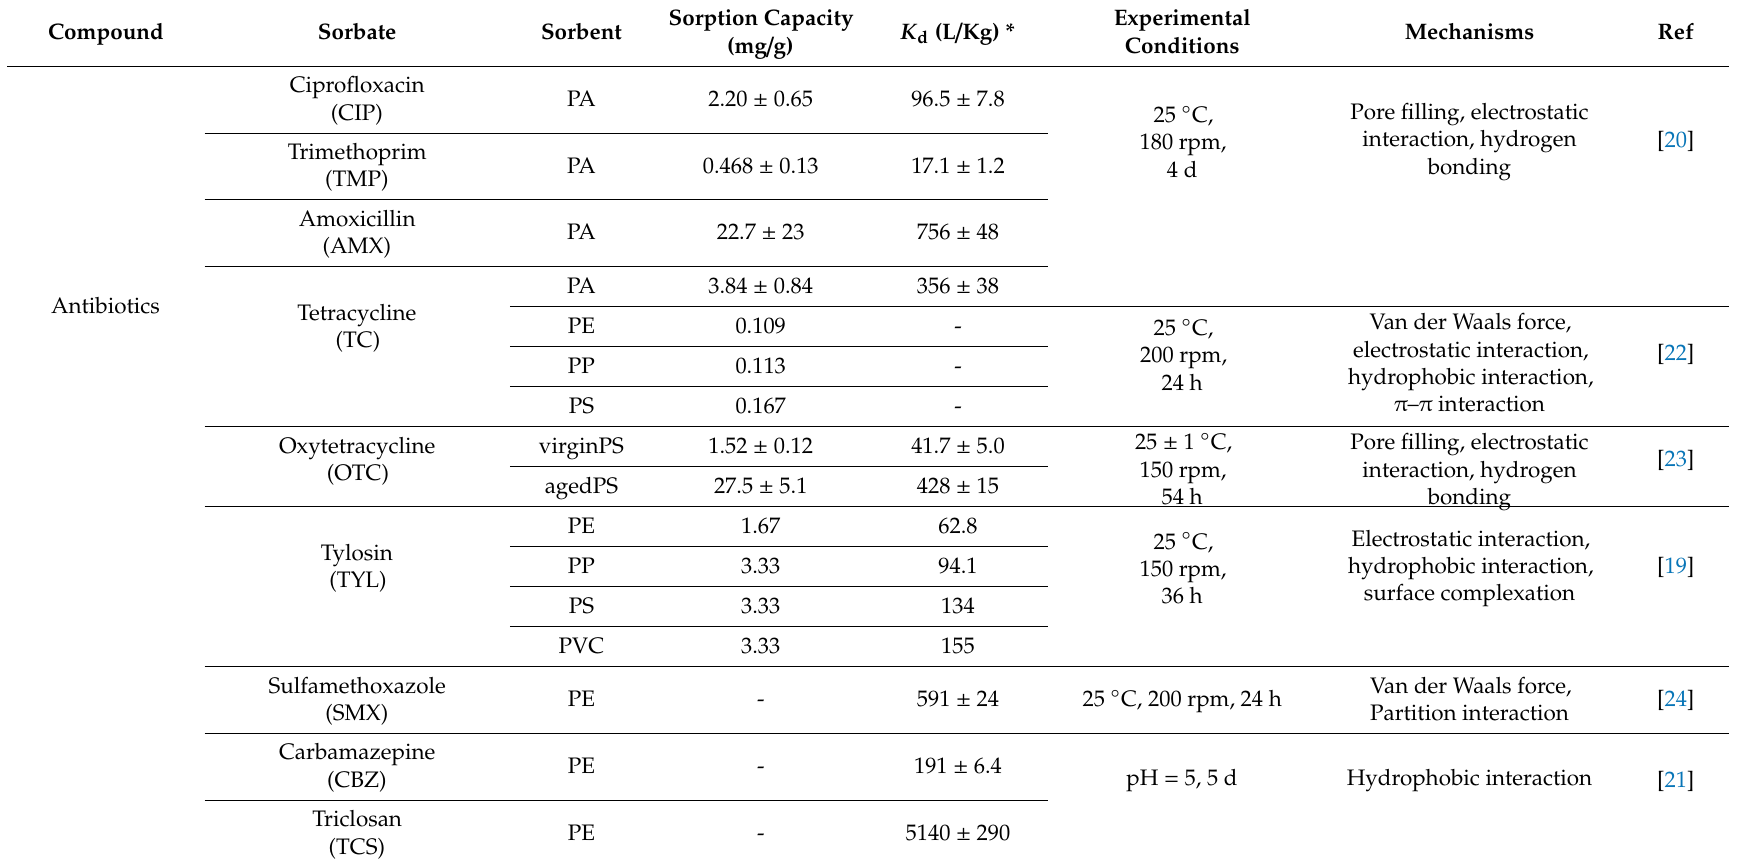
Table 1. Sorption parameters of di ff erent organic contaminants on NPs /